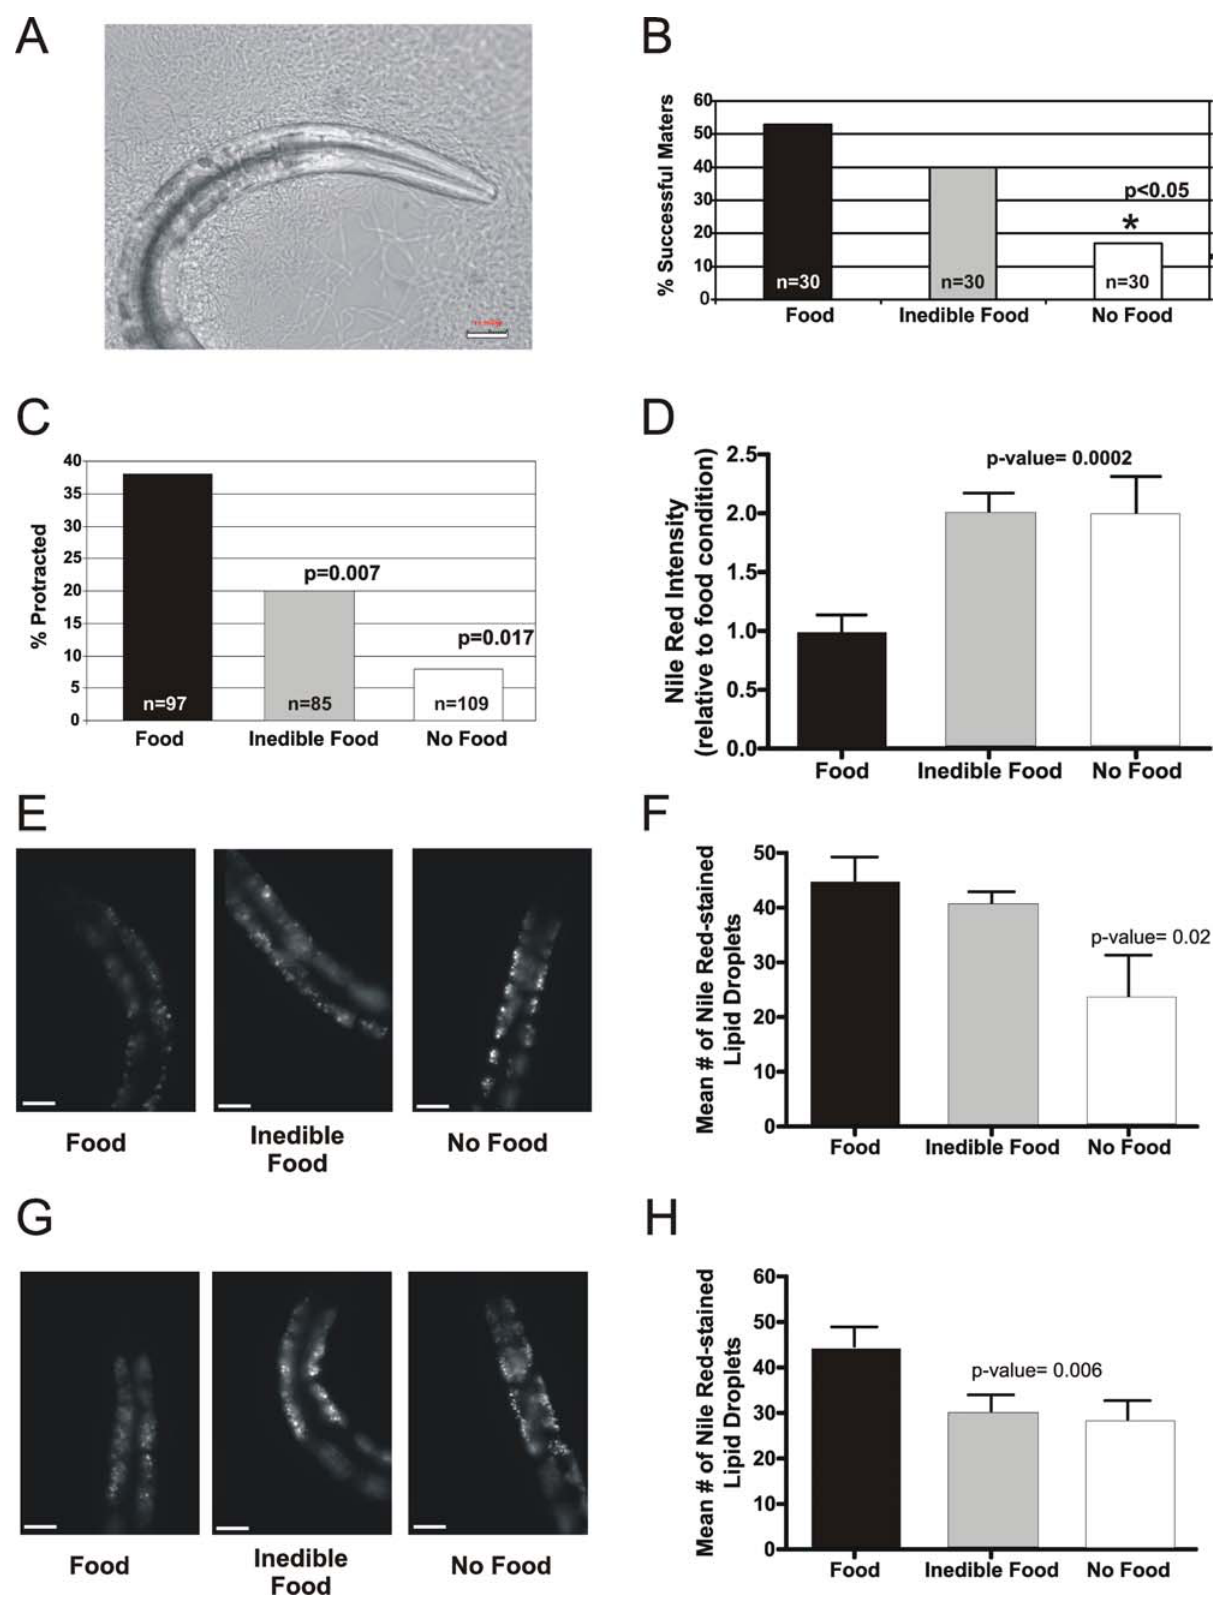
Figure 2. Food deprivation suppresses sex-muscle excitability via both internal and external sensory responses. (A) Adult male on aztreonam-treated E.coli OP50. Scale bar 20 m m. (B) Effects of food, inedible food, and no food on wild-type mating efficiency. p-value listed using Fisher’s exact test. (C) Effects of food, inedible food, and no food on unc-103(0) -induced seizures. p-value listed using Fisher’s exact test. (D) Bar graph